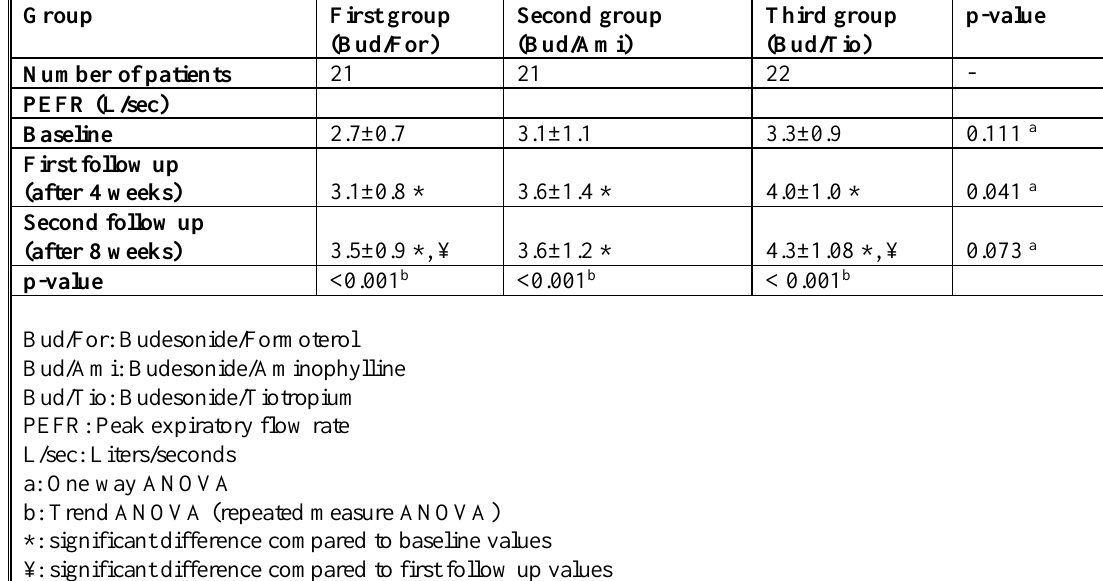
Table 3. Effect of study regimens on PEFR Group First group